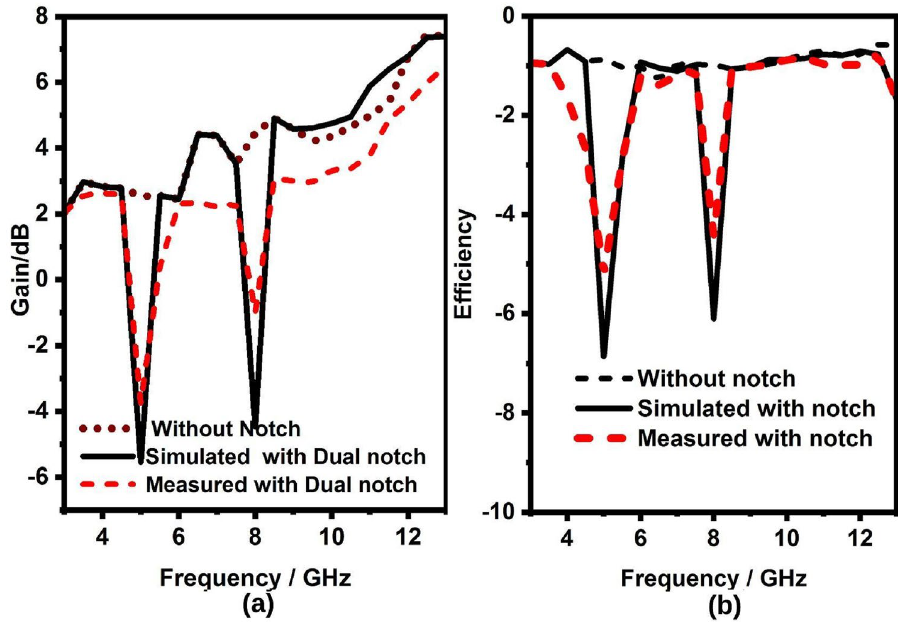
Figure 19. UWB sensing radiator ( a ) gain, ( b ) efficiency, 2